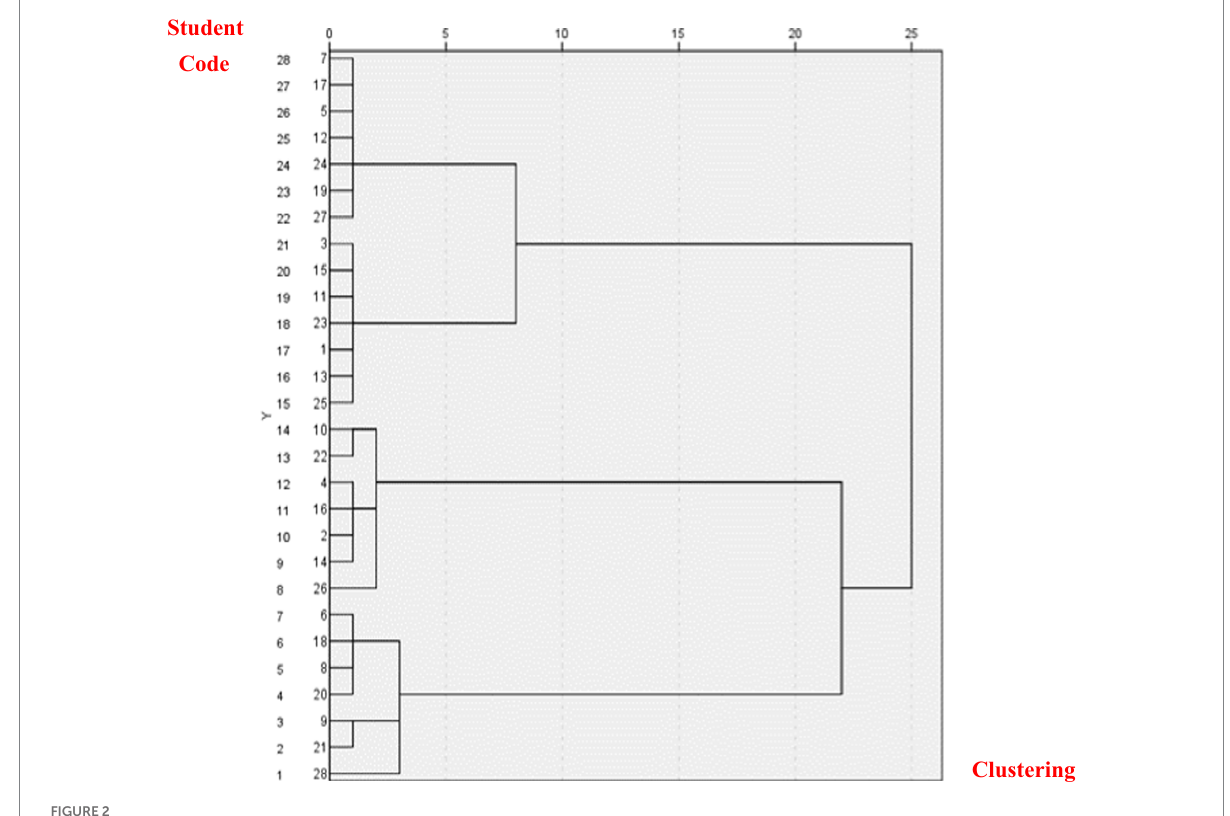
FIGURE 2 Cluster pedigree diagram.